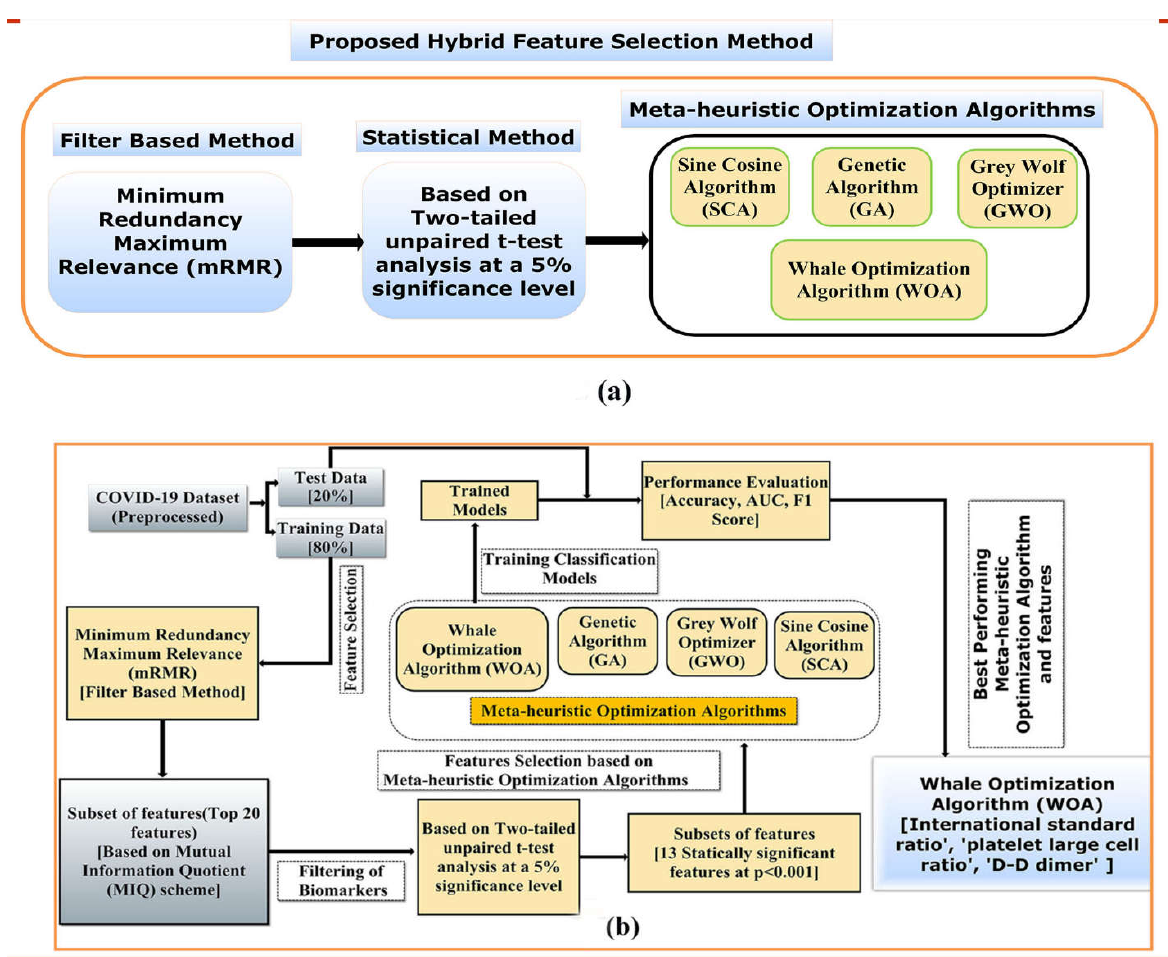
Figure 2. ( a ) Pictorial representation of the proposed hybrid feature selection method and ( b ) the workflow of the proposed hybrid feature selection method to screen the most informative ML model for predicting the mortality risk of COVID-19 individuals.